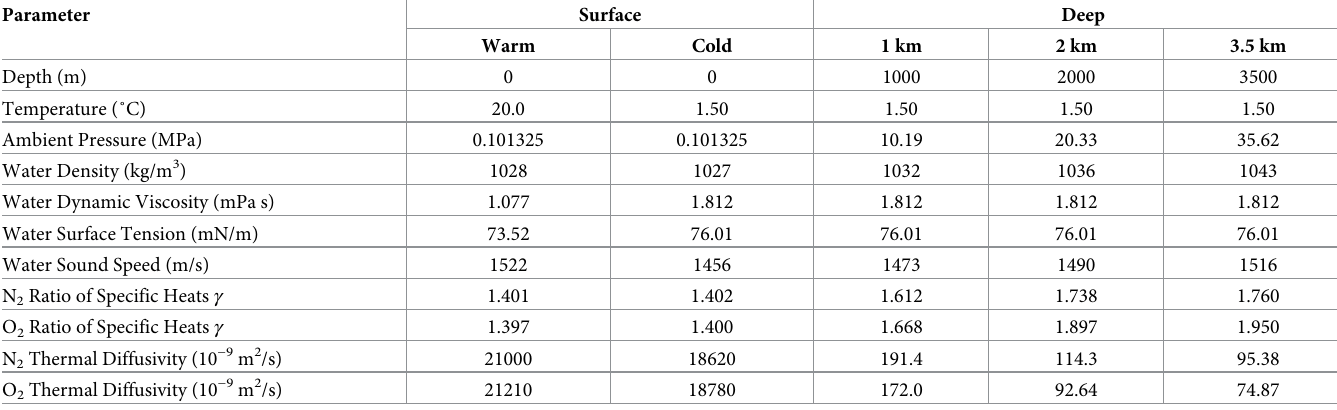
Table 1. Seawater, nitrogen, and oxygen parameters used to calculate bubble response curves and resonances. Parameter